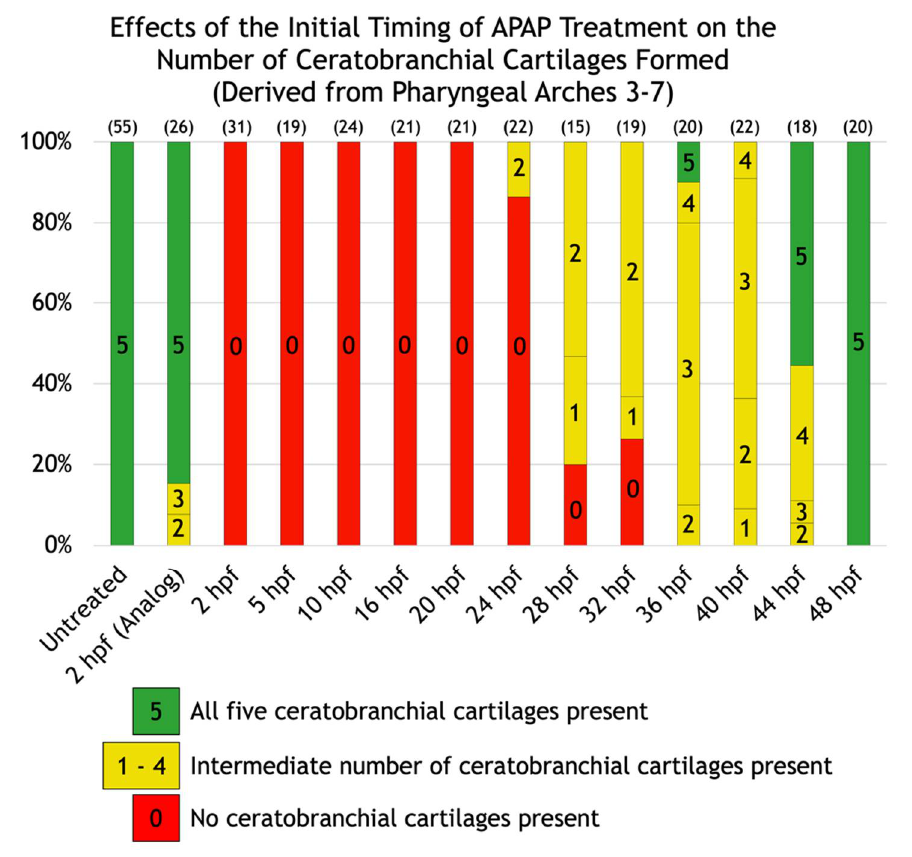
Figure 4. Effects of the initial timing of APAP treatment on the number of ceratobranchial cartilages formed (derived from pharyngeal arches three through seven). A quantification of the defects shown in Figure 2. The number of ceratobranchial cartilages formed are indicated within each bar. Green bars indicate all five ceratobranchial cartilages are present, yellow bars indicate an intermediate number, and red bars indicate none are present. The number of alcian blue-stained larvae analyzed for each group are in parentheses at the top of each column.